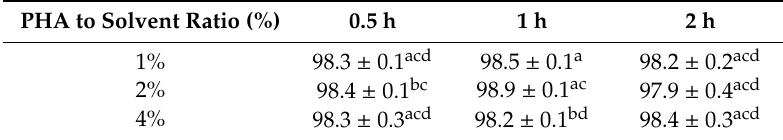
Table 3. Purity results by TGA of the samples submitted to the purification process by 1-butanol. The PHA to solvent ratio is written as in grams of PHA per 100 ml of solvent Values represent averages ± standard deviation of triplicates of percentage of purity of purified PHA.